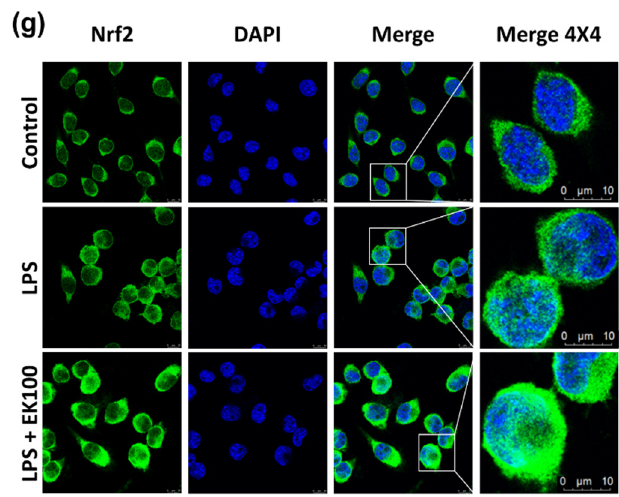
Figure 5. EK100 activated the Nrf2/HO-1 signaling pathway in LPS-stimulated macrophage-like cells. Cells were treated with 0, 10, 20, 40, and 80 µM EK100 before being stimulated with 100 ng/mL LPS. In RAW 264.7 cells: ( a ) The protein levels of the antioxidative transcription factor Nrf2 in the cytoplasm and cellular nucleus were measured by WB. ( b ) The protein expressions of HO-1, SOD1, SOD2, and CAT were measured. ( c ) Representative images showing the effect of 80 µM EK100 on Nrf2 protein expression were measured by IF staining. ( d ) Illustrative images of IF staining were showing the effect of 80 µM EK100 on HO-1 protein expression. In THP-1 cells: ( e ) Cells were treated with 0, 10, 20, 40, and 80 µM EK100 before being stimulated with LPS for 24 h. WB analyzed the protein levels of Nrf2 in the cellular cytoplasm and cellular nucleus. In BV2 cells: ( f ) Cells were treated with 0, 10, 20, 40, and 80 µM EK100 before being stimulated with LPS for 24 h. The protein levels of Nrf2 in the cellular cytoplasm and cellular nucleus were measured by WB. ( g ) Illustrative images of IF staining showed the effect of 80 µM EK100 on Nrf2 protein expression in BV2 cells. In RAW 264.7 cells: All the experiments were designated in Materials and Methods. All results were expressed as folds mean ± SEM compared with β -actin in the cytoplasm or PCNA in the cellular nucleus of three independent experiments ( n = 3). # p < 0.05 compared with the control group, * p < 0.05, ** p < 0.01, and *** p < 0.001 compared with the LPS alone group.